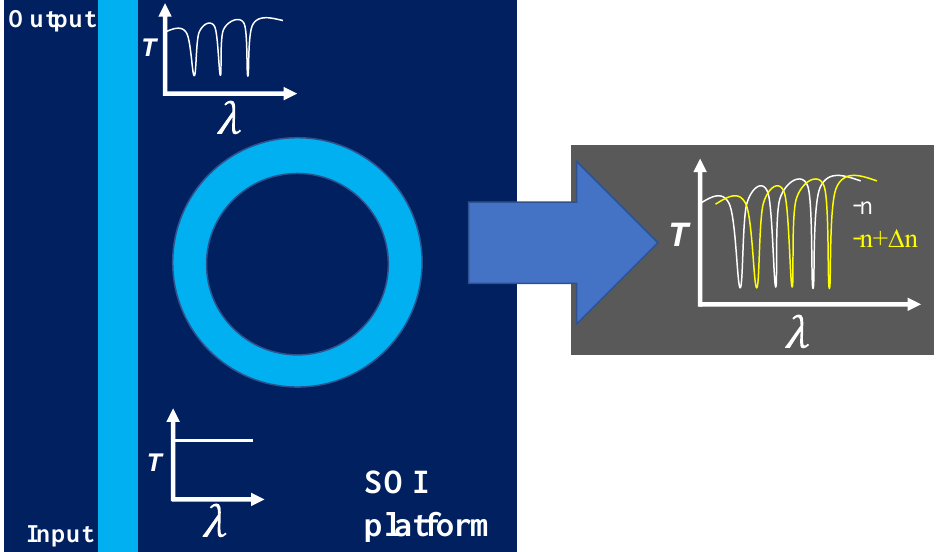
Figure 2. Typical schematic representation of RR established on SOI platform ( left ) and transmission spectrum ( right ).